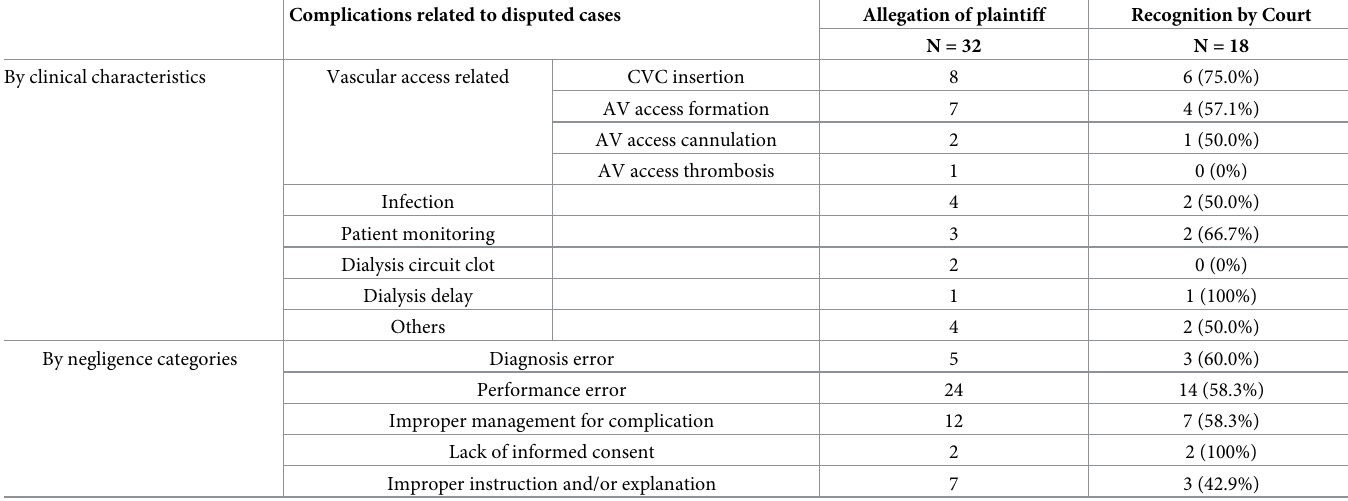
Table 2. Classification of reason for litigation.